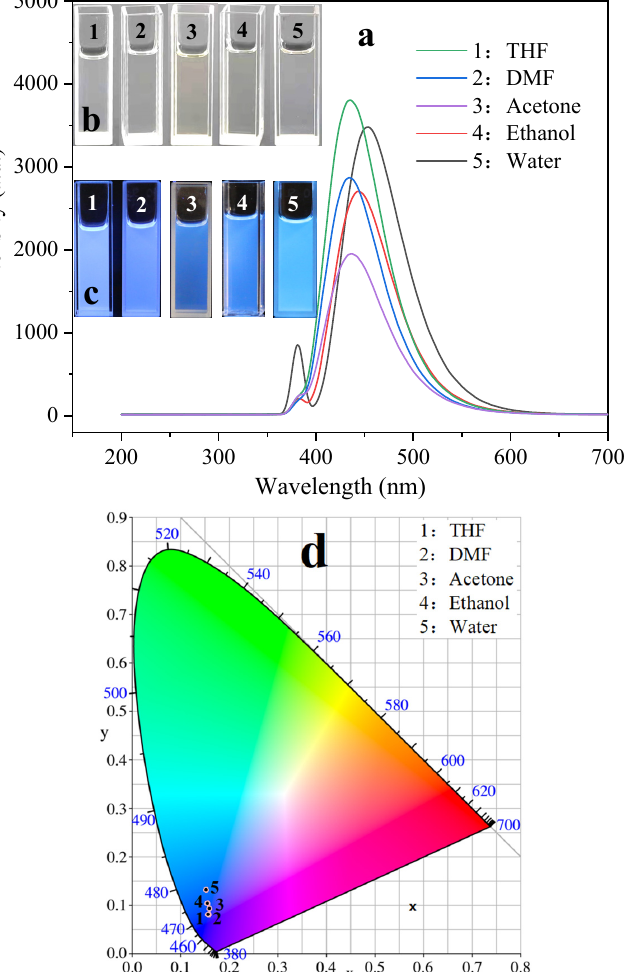
Figure 6. The fluorescence emission spectra of poly 14 -N-CQDs in different solvents ( a ); photos of poly 14 -N-CQDs in different solvents under visible light ( b ) and under UV light ( c ); the CIE chromaticity diagram of poly 14 -N-CQDs in different solvents ( d ).